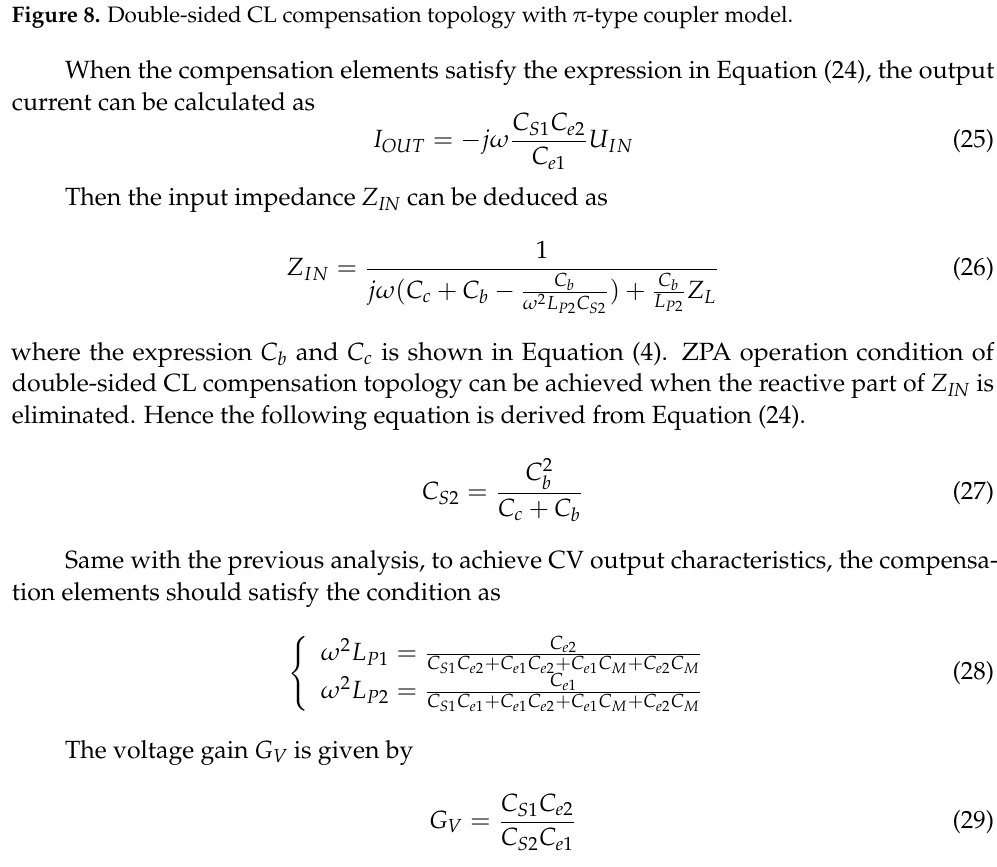
Figure 10. CL − LC compensation topology with T-type coupler model.